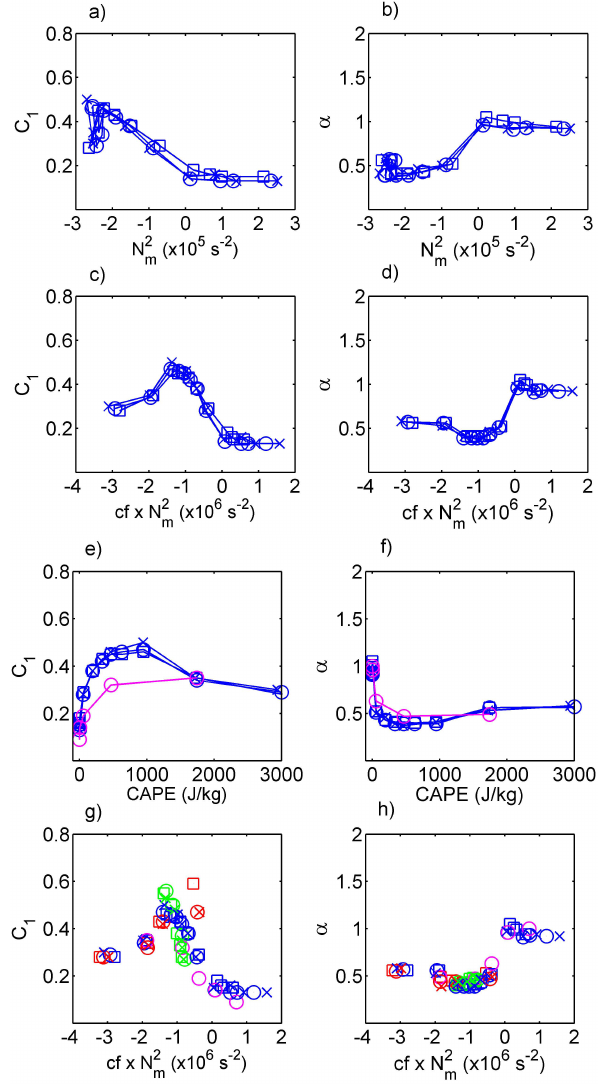
Fig. 11. C 1 and α computed from 3-D averages of q c horizontal fluctuations against: (a, b) N 2 m ; (c, d) cf × N 2 m ; and (e, f) CAPE. Blue lines and markers are computed from simulations with vary- ing T s and l sst = 10km, pink from simulations with varying T s and l sst = 5km, red for varying τ adv and green for varying l sst . Plots (g, h) show C 1 and α against cf × N 2 m for all simulations. Black mark- ers in plots (b) and (h) represent simulation Sst10km (i.e., the base case). “x”, “o” and “ (cid:3) ” markers represent simulation times 05:00h, 04:00h and 03:00h,